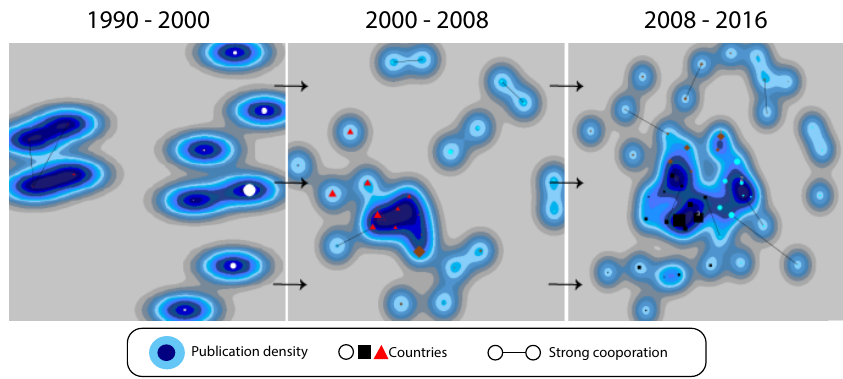
Figure 9. Evolution of Country Networks